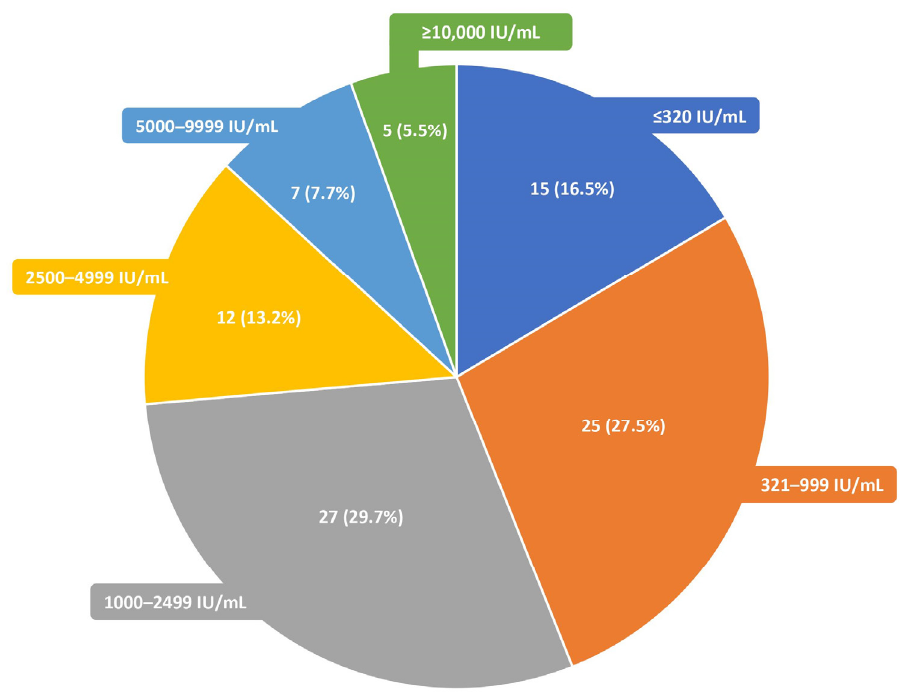
Figure 2. The distribution of EBV DNA load (IU/mL) in the whole blood ( n = 91) for the correspond- ing negative plasma samples ( n = 91).